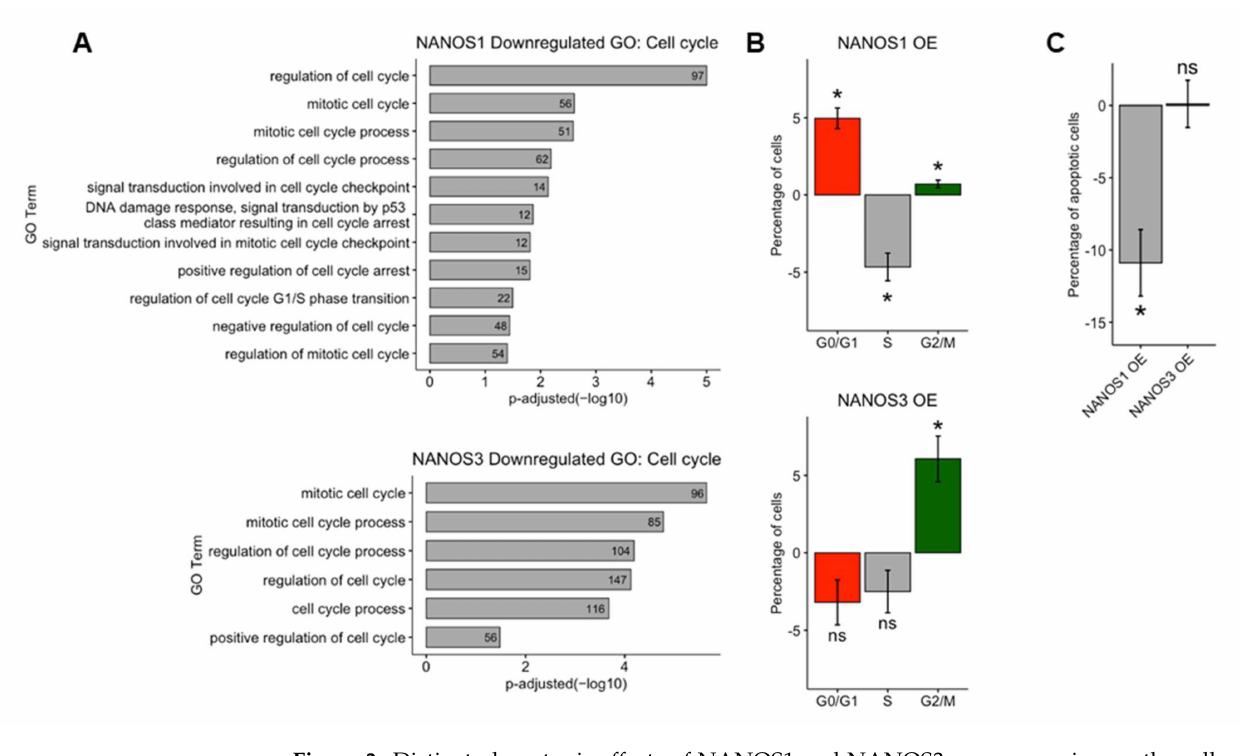
Figure 3. Distinct phenotypic effects of NANOS1 and NANOS3 overexpression on the cell cycle. ( A ) Cell cycle related biological processes downregulated upon NANOS1 (top panel) and NANOS3 (bottom panel) overexpression identified in GO analysis. ( B ) Cell cycle analysis by propidium iodide staining followed by flow cytometry analysis upon NANOS1 (top panel) and NANOS3 (bottom panel) overexpression. ( C ) Apoptosis analysis by Annexin-V staining followed by flow cytometry analysis upon NANOS1 and NANOS3 overexpression. Standard error is visualized as error bars. * = p -value ≤